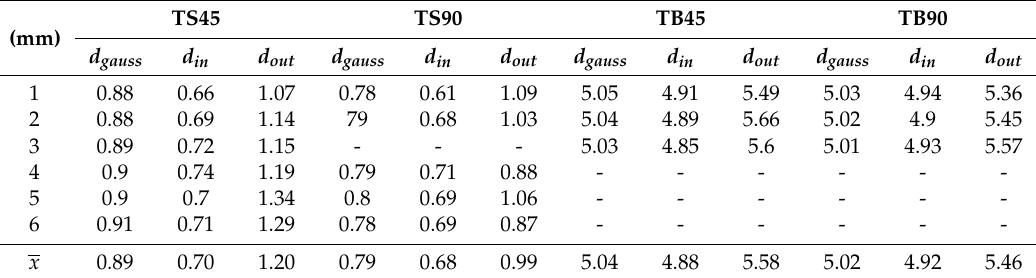
Table 5. The dimensions of the tensile specimen specimens with different orientation to the platform (multi-struts tensile specimens TS-series; bulk tensile specimens TB-series).